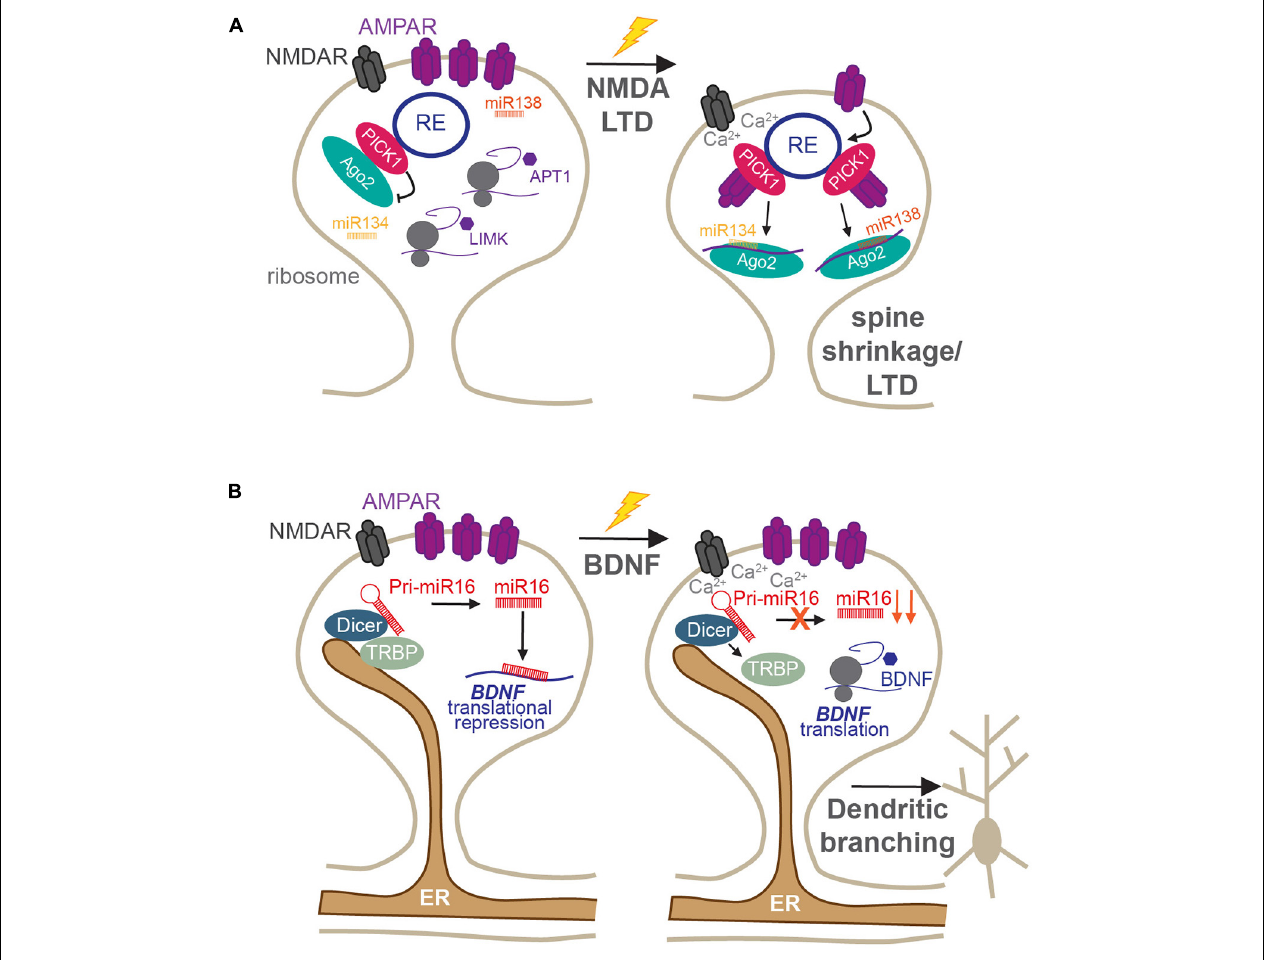
FIGURE 3 | Roles of membranous organelles in the regulation of local protein synthesis at synapses. (A) The Ca 2 + -sensing AMPAR trafficking protein PICK1 regulates the activity of Ago2 in dendritic spines. Under basal conditions, PICK1 directly recruits Ago2 to recycling endosomes which reduces Ago2 silencing of miR134-LIMK1 and miR138-APT1 and maintains enlarged spines. Following NMDA receptor stimulation, the local rise in Ca 2 + -concentration disrupts PICK1-Ago2 interactions. This increases the affinity of PICK1 for AMPARs, enhancing their internalization, increases Ago2-mediated miR134-LIMK1 and miR138-APT1 silencing, and supports persistent LTD (Antoniou et al., 2014; Rajgor et al., 2017, 2018). (B) The ER is present within dendrites and spines, where it scaffolds Dicer complexes to locally control miRNA biogenesis. Under basal conditions, miR16 is processed locally to translationally repress BDNF and inhibit dendritogenesis. Following BDNF stimulation, TRBP dissociates from Dicer in a calcium-dependent manner, resulting in reduced miR16 maturation and increased translation of BDNF to increase dendritic growth (Antoniou et al.,